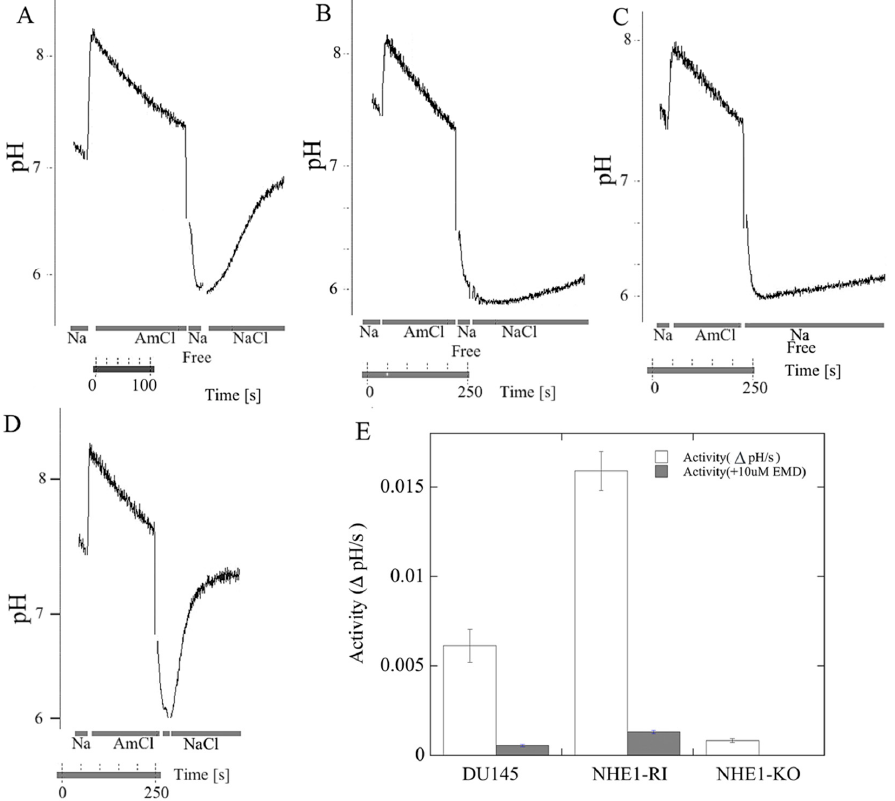
Figure 2. Na + /H + exchanger activity in parental DU 145 cells, in NHE1-knockout cells (NHE1-KO), and in knockout cells that had NHE1 reintroduced (NHE1-RI). ( A – D ) Examples of traces of activity; these illustrate recovery from an acutely induced acid load. The intracellular pH was recorded in cells transiently acidified using ammonium chloride addition. Periods when NH 4 Cl, NaCl, and Na-free solution were added are indicated. ( A ) wild-type DU 145cells; ( B ) KO cells; ( C ) wild-type cells recovered from acid load in the absence of Na + ; ( D ) RI: KO cells with NHE1 reintroduced (knock-in). ( E ) Bar graph showing a summary of the initial rate of recovery; this was measured relative to the wild-type protein and recorded as delta pH/s. n ≥ 6, mean +/ − SE. A pH-sensitive indicator dye, BCECF, was used to measure changes in pH i after the acute acid load induced by the addition and withdrawal of ammonium chloride. The activity of NHE1 was calculated from the changes over the first 20 s of recovery from the acid load, and was expressed as Δ pH/s. Where indicated in ( E ), 10 μ M EMD87580 (EMD) was included in the recoveries to confirm that activity was from Na + /H + exchanger activity.